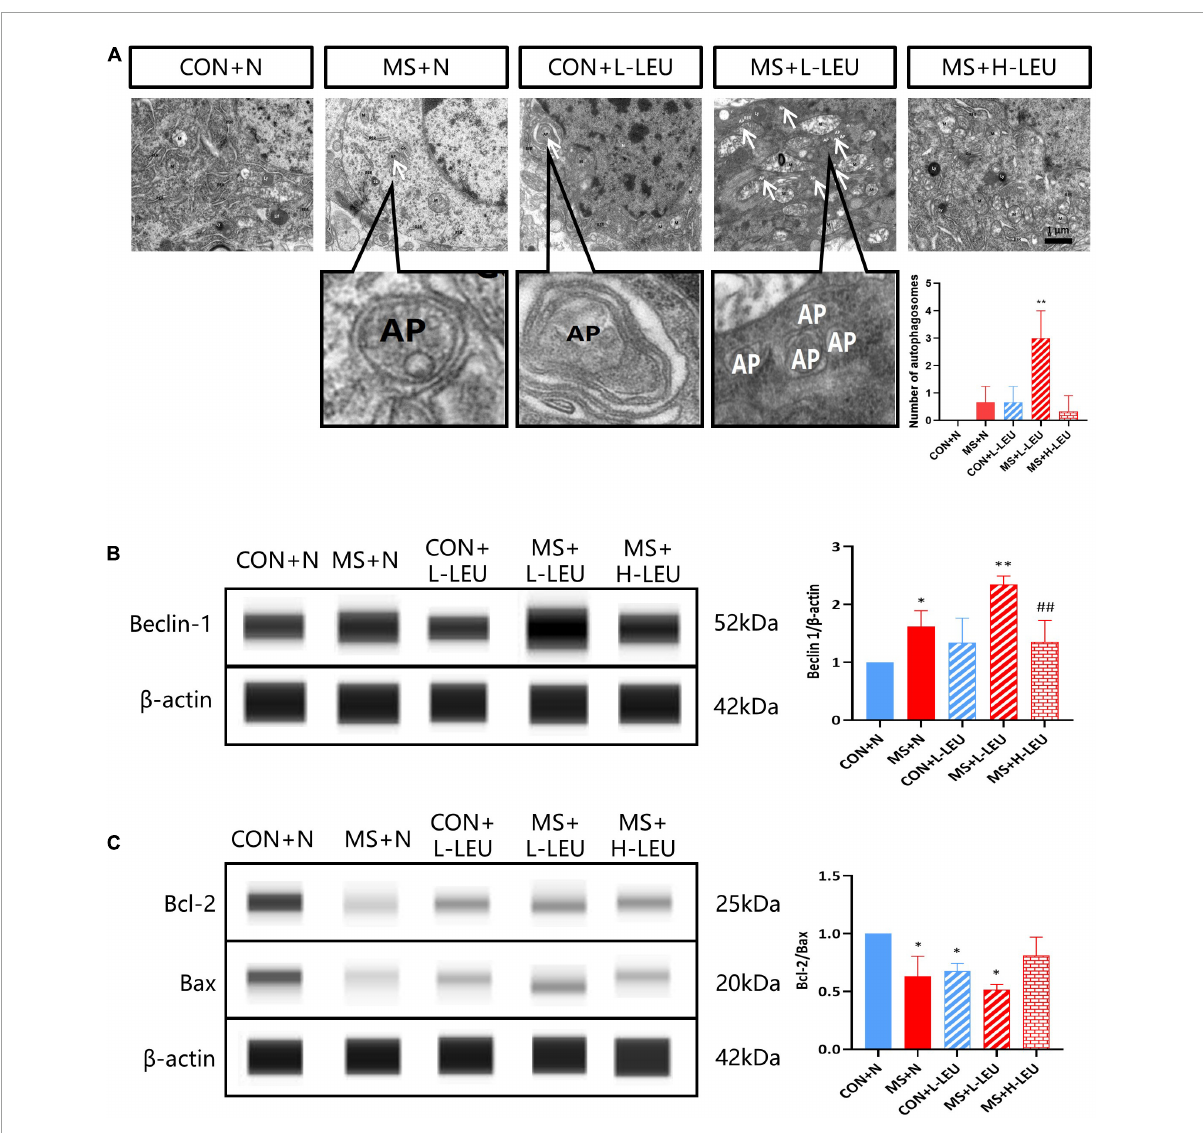
FIGURE4 Leucine plays an important role in the development of cognitive impairment induced by maternal separation stress. (A) The autophagosomes in the hippocampus were detected by a transmission electron microscopy. Existence of the cytoplasmic components enclosed in double-membraned vesicles is the hallmark of autophagosomes (Eskelinen, 2008). (B) Beclin-1 in the hippocampus was detected by WES. (C) Bcl-2 and Bax were detected by WES. ∗ p < 0.05, ∗∗ p < 0.01 vs. CON + N, ## p < 0.01 vs. ME + L-LEU, n =